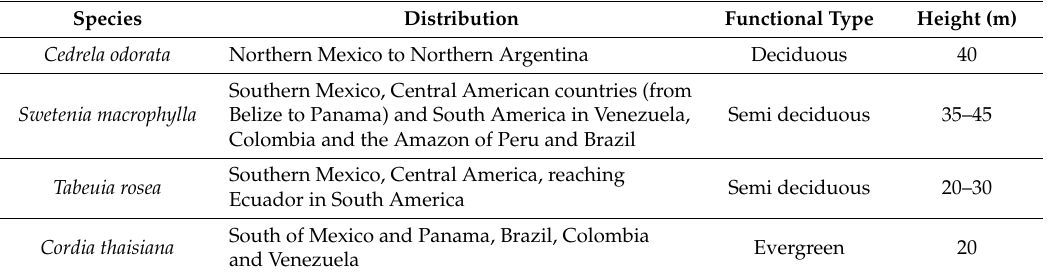
Table 1. Distribution, functional type (leaf phenology), and tree height of four timber